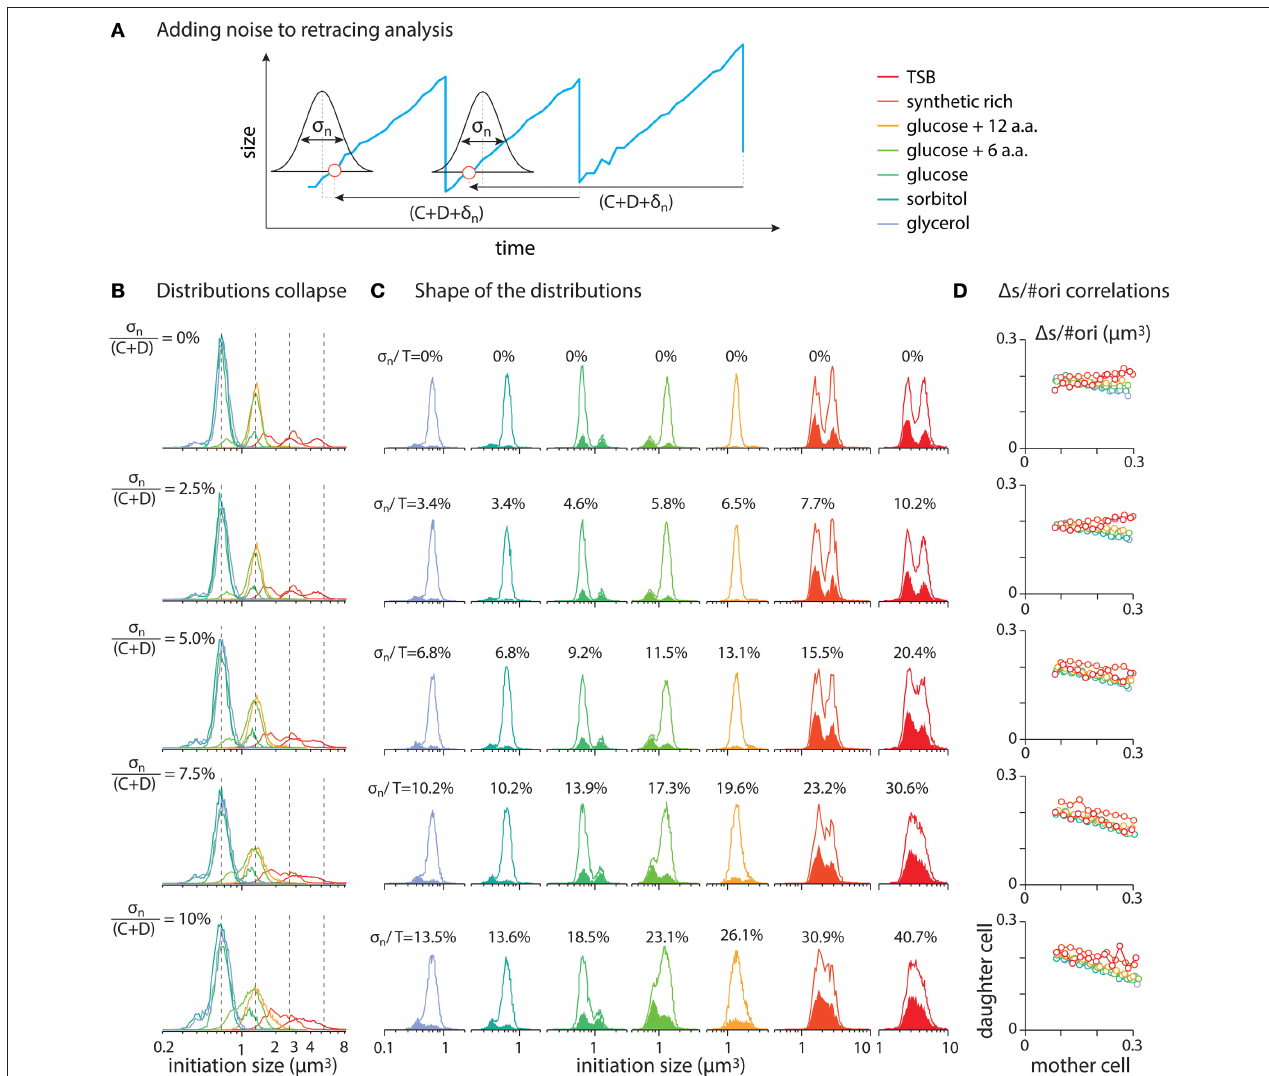
FIGURE A2 | (A) To test the effect of noise in the analysis, a Gaussian noise δ n with standard deviation of standard deviation of σ n is added to the retracing time. (B) Various levels of noise is tested with standard deviations, σ n , chosen at 0, 2.5, 5, 7.5, and 10% of C + D. (C) Solid lines refer to the distribution from whole cell population and filled area refer to cells with double initiations in a division cycle. Standard deviation, σ n , in each row is the same as the one in the corresponding row in (B) . The ratio of the standard deviations, σ n , to the average doubling time, T , is noted on the left side of each sub panel. (D) Mother-daughter correlations of 1 s / # ori with noise added in